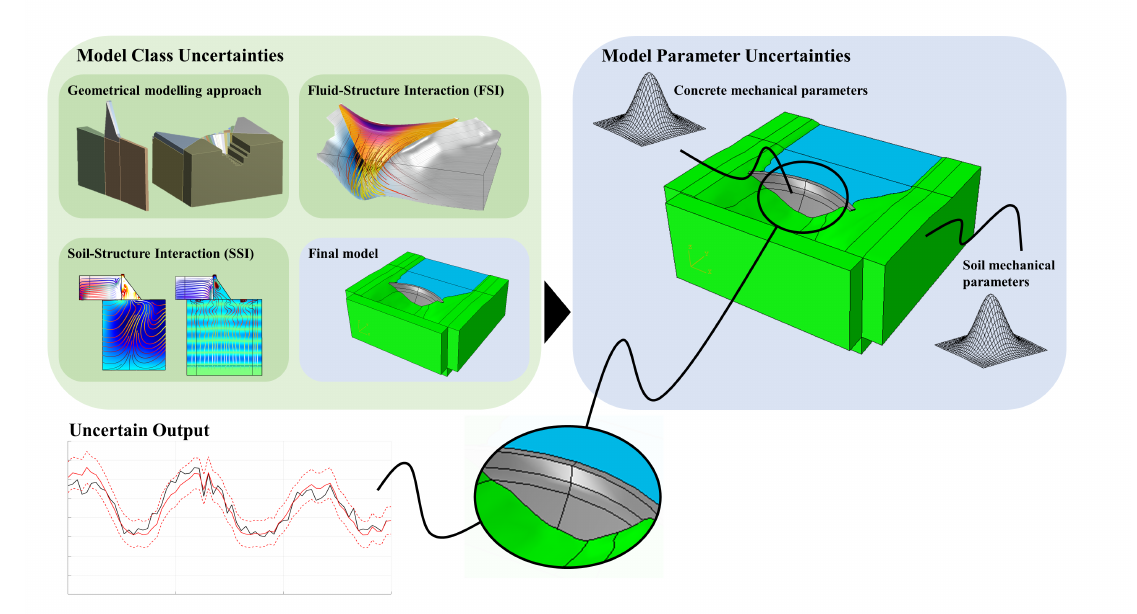
Figure 2. Classification of epistemic uncertainties in dam